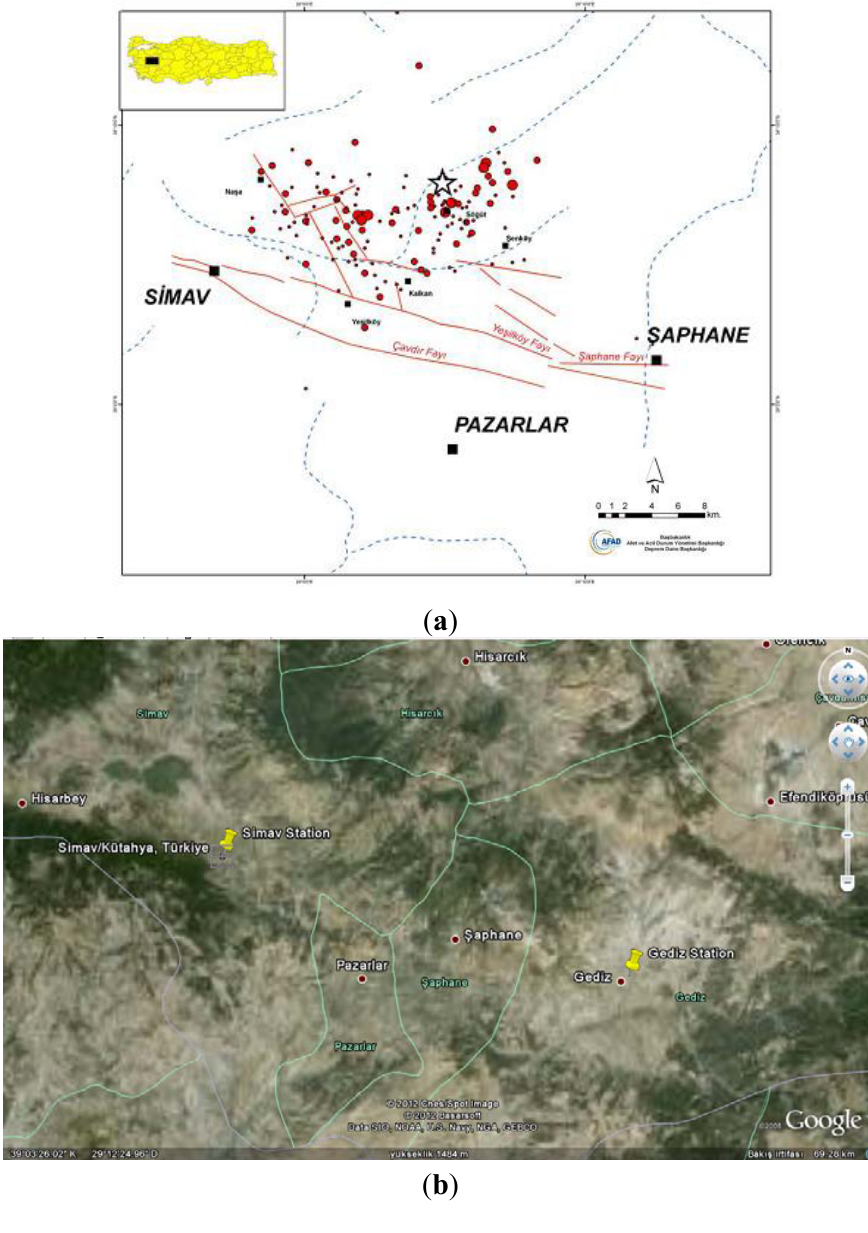
Figure 3. ( a ) Fault lines near Simav—epcienter shown by star [3]; ( b ) and Google Earth view of Simav and Gediz Stations. (Star in the map indicates earthquake epicenter and circles represent